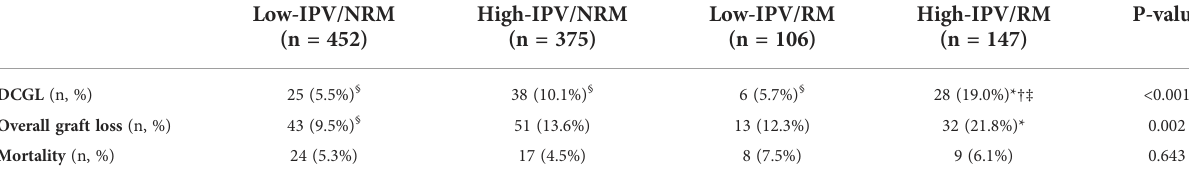
TABLE 3 DCGL, overall graft loss, and mortality rates according to TAC-IPV and RM/NRM status.